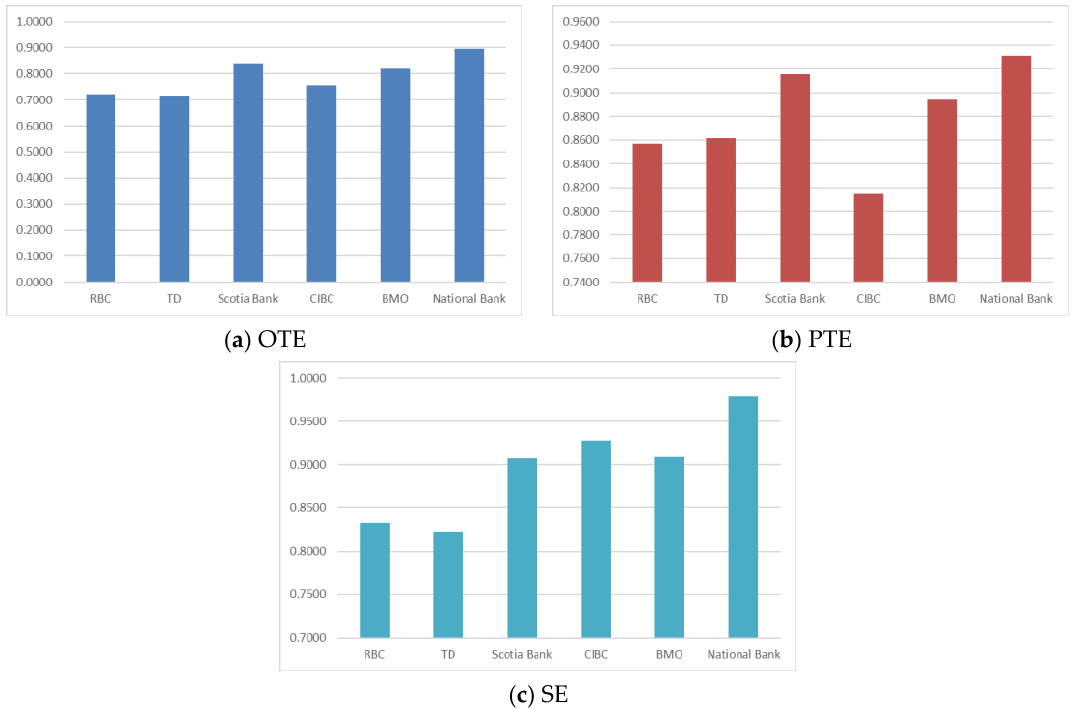
Figure 6. Banks’ bootstrap OTE, bootstrap PTE, and the SE for the second stage . J. Risk Financial Manag. 2020 , 13 , x FOR PEER REVIEW